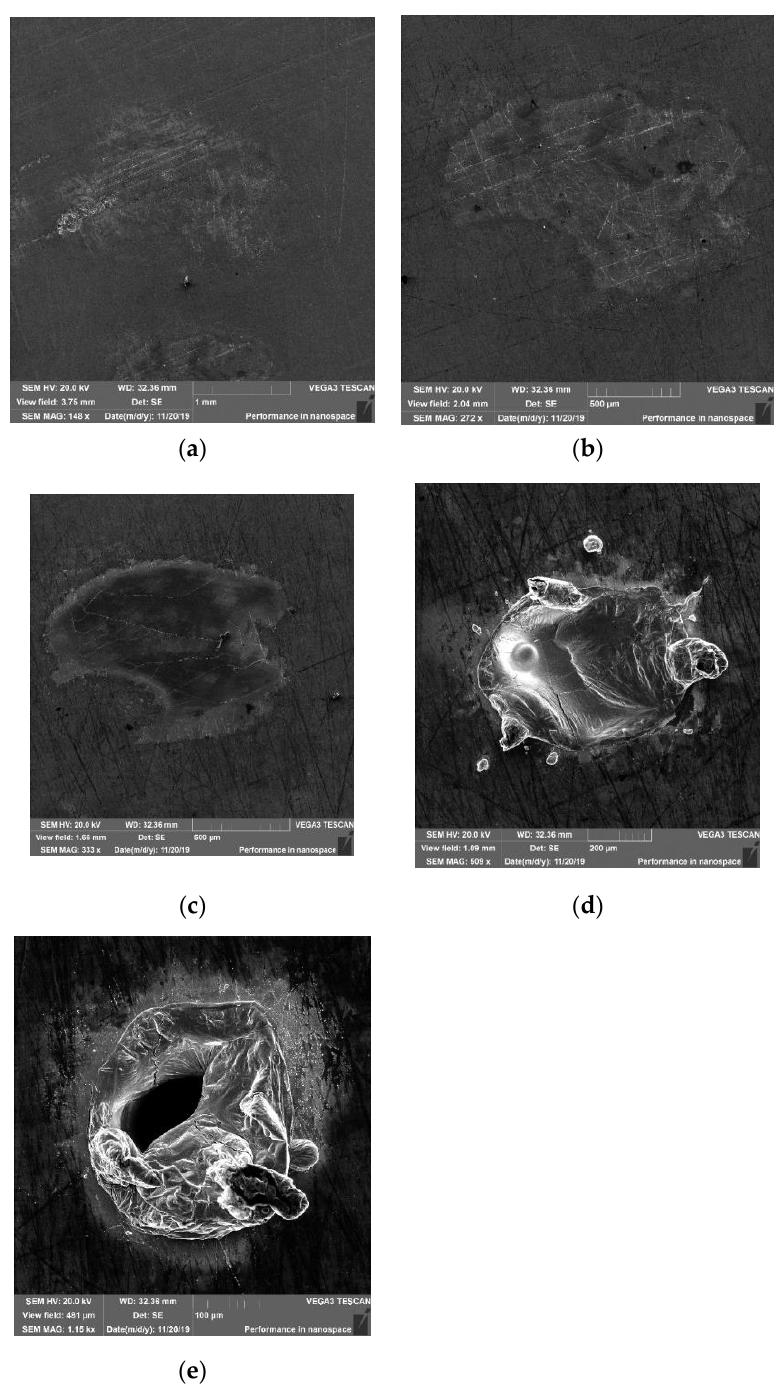
Figure 3. SEM micrographs of the spots on bulk samples for fluencies ε = 5.43; 6.97; 13.0; 24.5; 32.0 J · cm − 2 : ( a ) spot No. 7, ε = 5.43 J · cm − 2 ; ( b ) spot No. 6, ε = 6.97 J · cm − 2 ; ( c ) spot No. 5, ε = 13.0 J · cm − 2 ; ( d ) spot No. 4, ε = 24.5 J · cm − 2 ; ( e ) spot No. 3, ε = 32.0 J · cm − 2